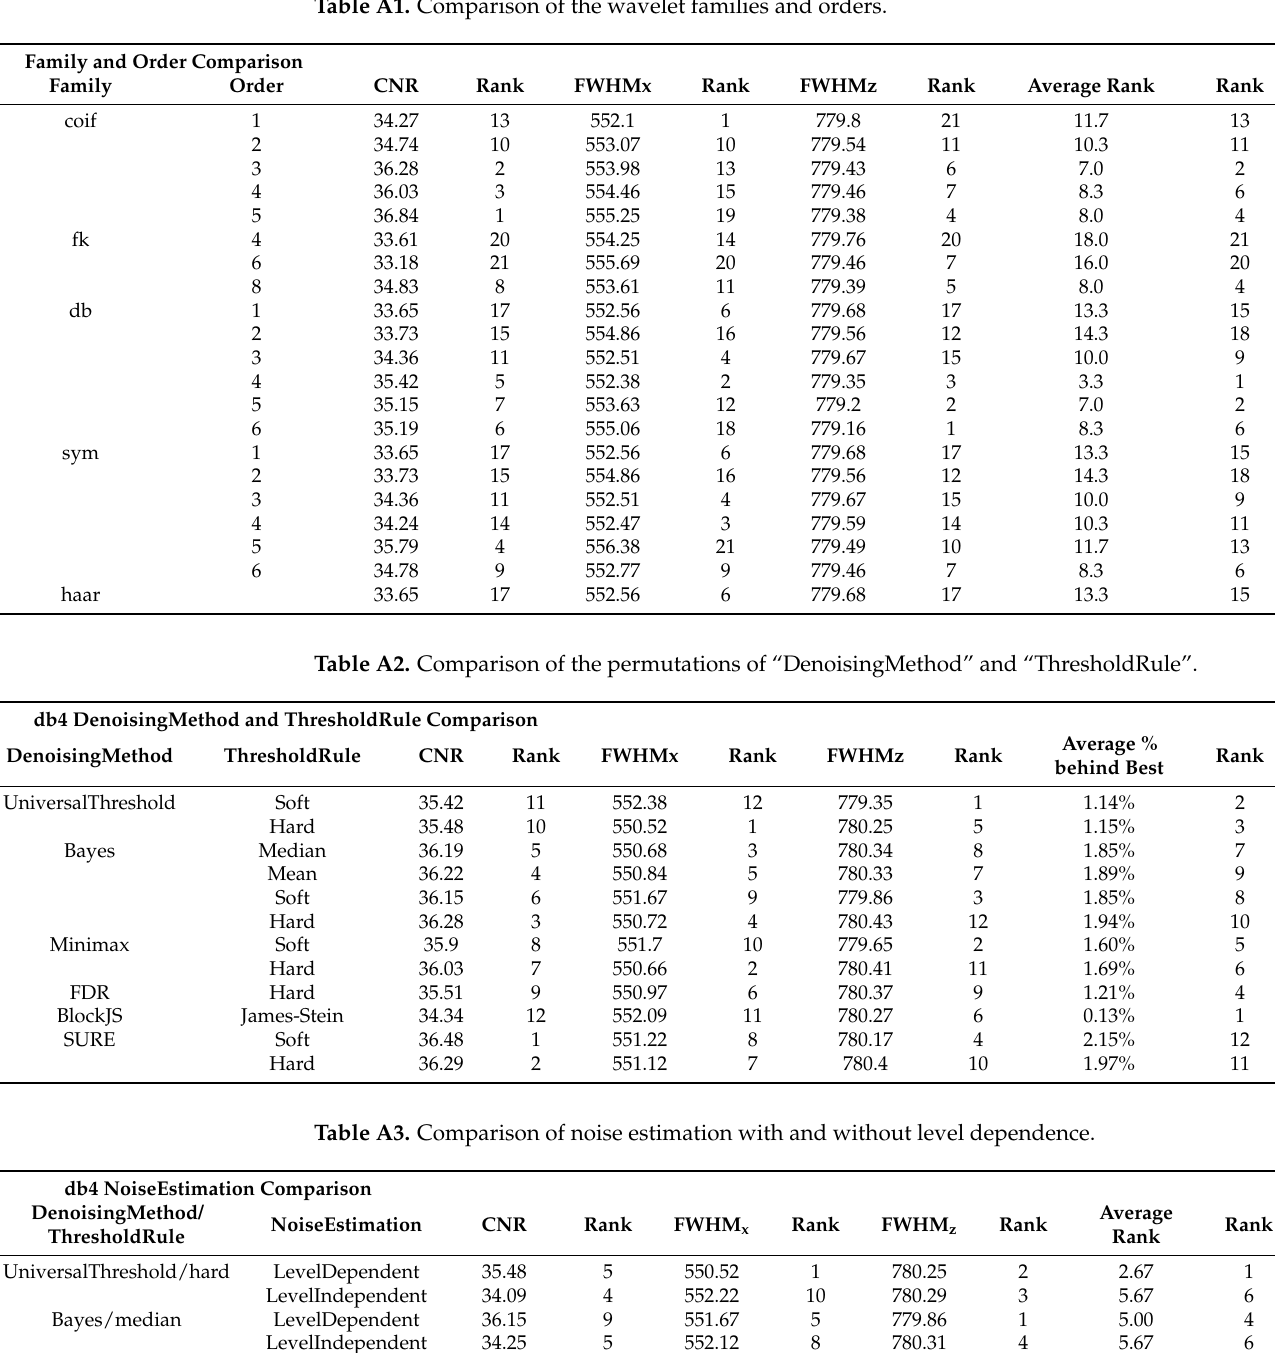
Table A1. Comparison of the wavelet families and orders.